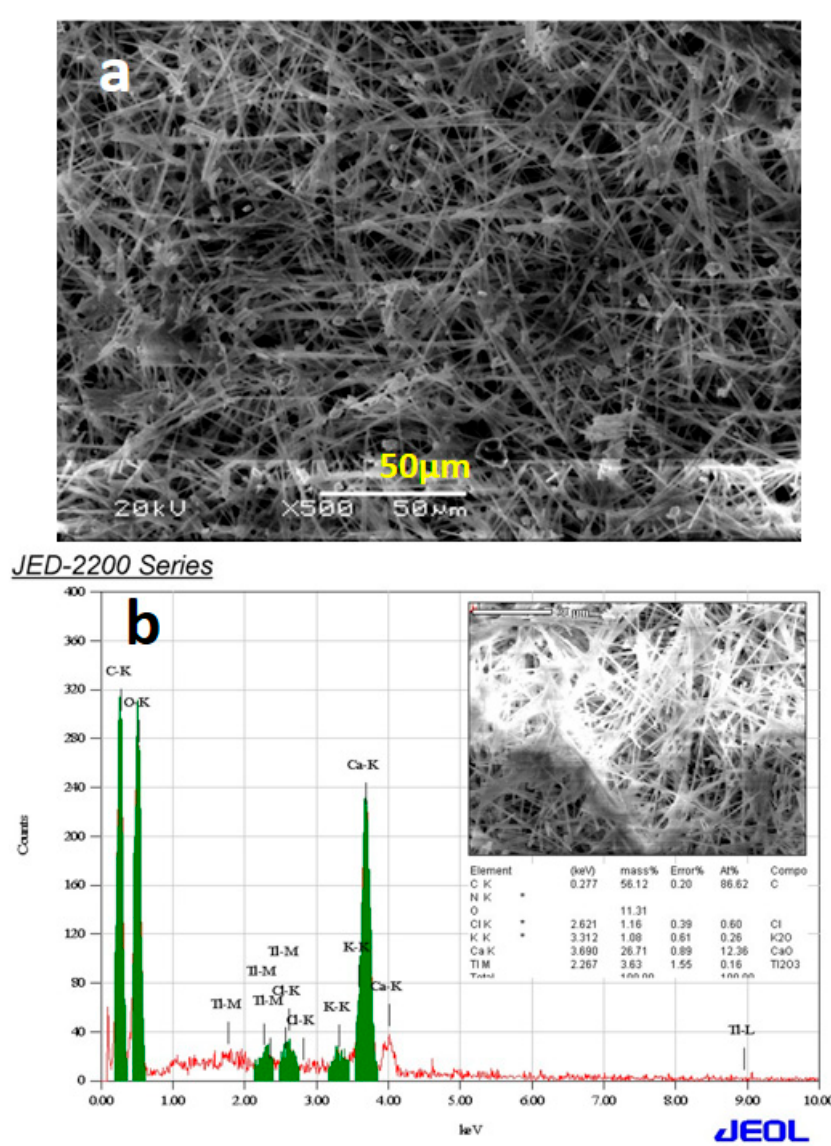
Figure 8. ( a ) Scanning electron microscopy (SEM) image; and ( b ) EDX of S. persica L. root extract.